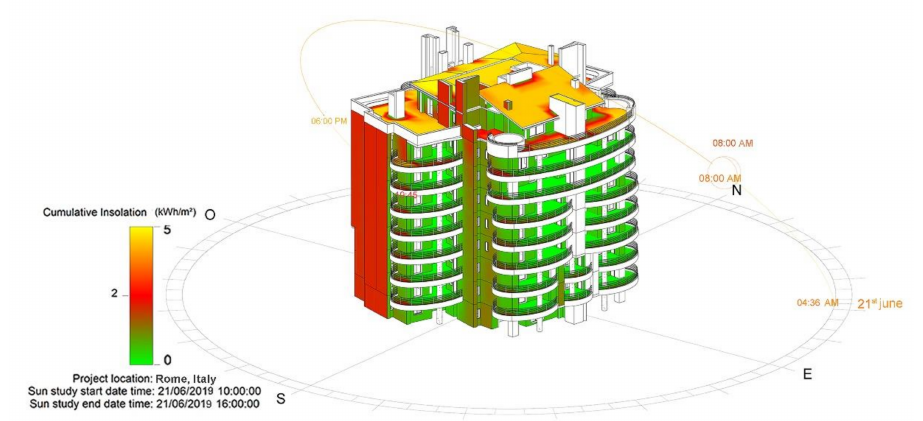
Figure 9. Solar radiation